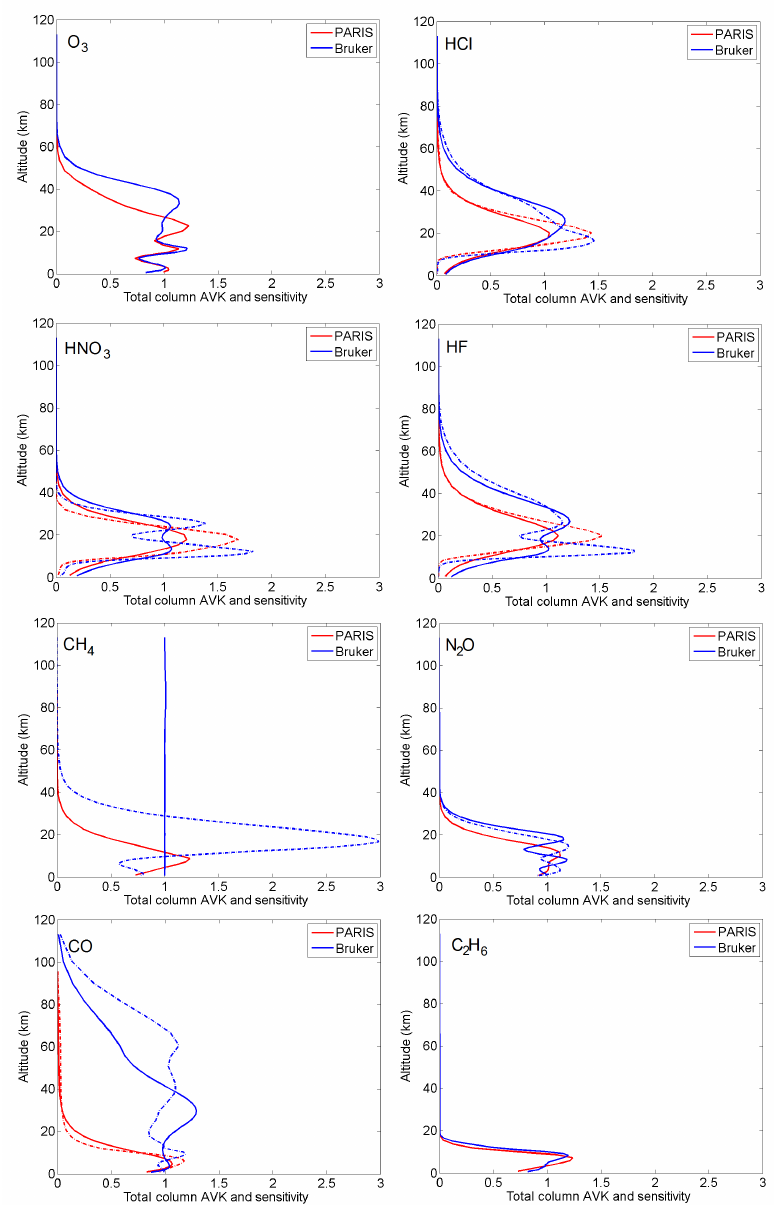
Figure 1. Example of a total column averaging kernel (AVK, solid lines) and sensitivity (dashed-dotted lines) of the retrieval are shown for each of the eight species for PARIS-IR (red) and the Bruker 125HR (blue). If no dashed-dotted line is shown in the figure, the sensitivity and total column averaging kernel are too similar to distinguish the difference on the